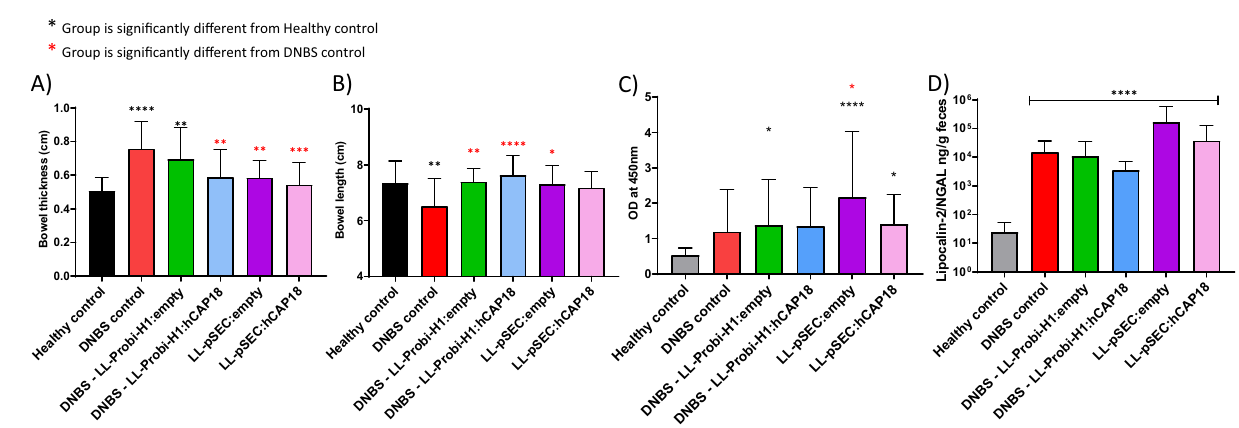
Figure 2. Effects of preventive treatment on DNBS-induced tissue damage and inflammation. Assessments of ( A ) bowel thickness, ( B ) bowel length, ( C ) MPO activity, and ( D ) lipocalin in feces in control groups (PBS-glycerol, DNBS) and treatment groups (LL-Probi-H1:empty, LL-Probi-H1:hCAP18, LL-pSEC:empty, LL-pSEC:hCAP18). Data represent mean ± SD. *P < 0.05, **P < 0.01, ***P < 0.001, ****P < 0.0001, n = n = 24 mice per group for LL-Probi-H1:empty and LL-Probi-H1:hCAP18, n = 16 for LL-pSEC:empty and LL-pSEC:hCAP18, n = 20 mice for healthy